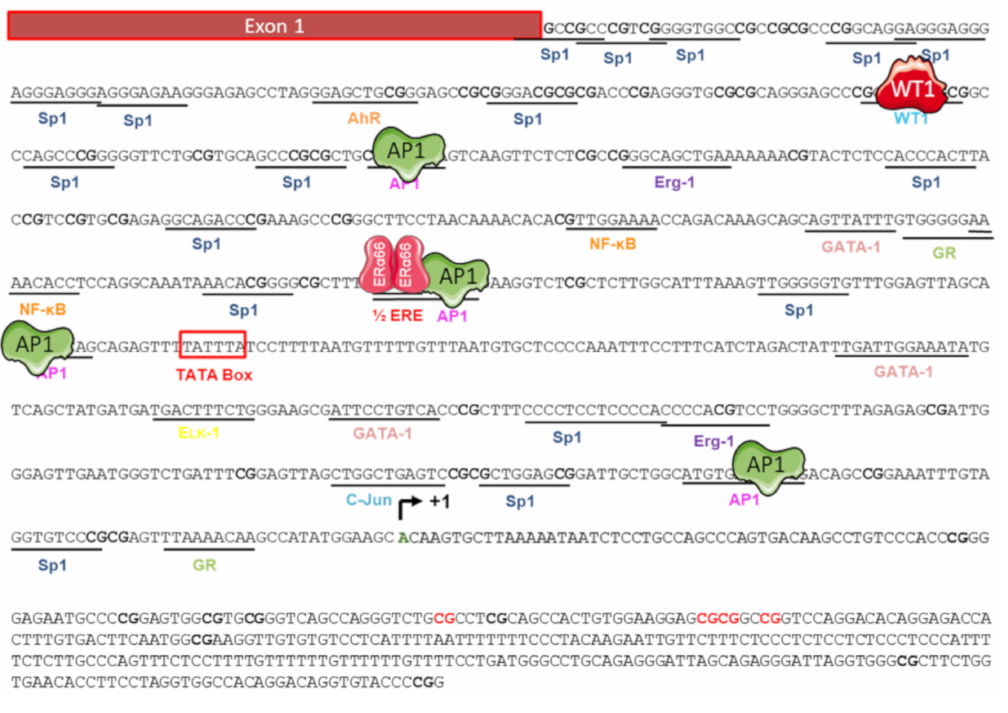
Figure 5. Regulators of the ER α 36 promoter activity. The nucleotide sequence of the 5 (cid:48) flanking region of ER α 36 gene was cloned by Zou and colleagues in 2009 [82]. Putative binding sites of the transcription factors AP1, Sp1, AhR, NF- κ B, and WT1, and an ERE half site, are underlined. The putative TATA box is shown as an open box. Various studies have demonstrated that activity of the ER α 36 promoter is positively (green) regulated by AP1 but negatively (red) regulated by WT1 and the canonical form ER α 66. The ER α 36 transcription start site is indicated (curved arrow + 1) in bold green. CpG dinucleotides are in bold and those whose level of methylation is correlated with ER α 36 expression are indicated in bold red [84]. Adapted from